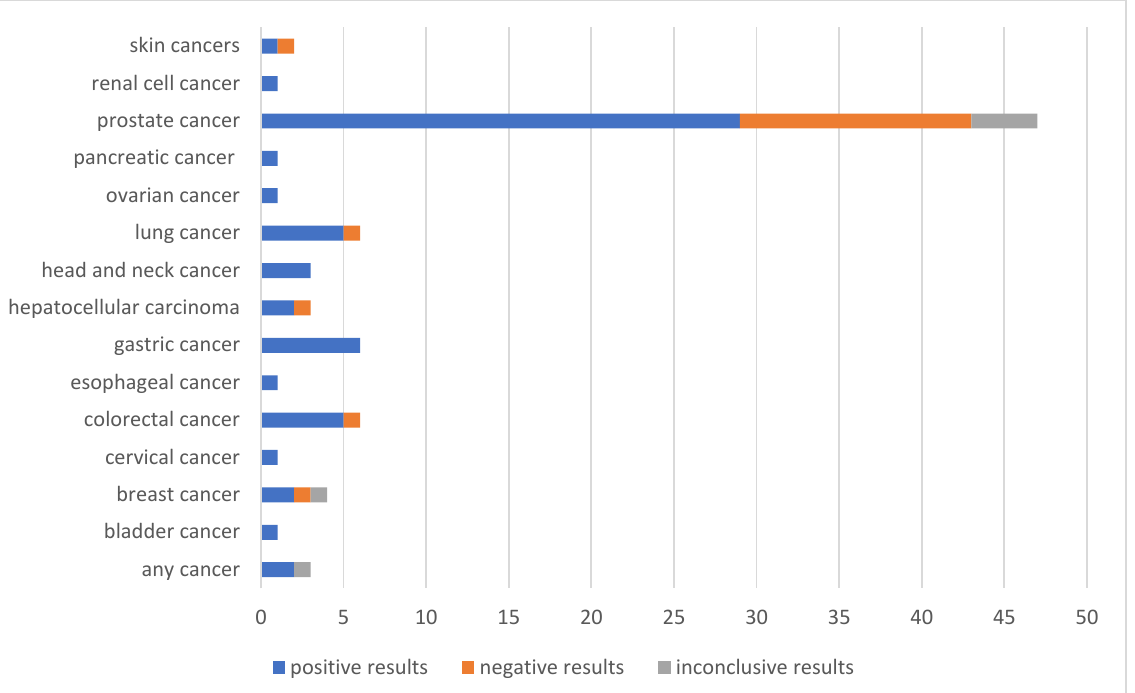
Figure 2. Outcomes of in vivo studies on the anti-cancer effect of lycopene.